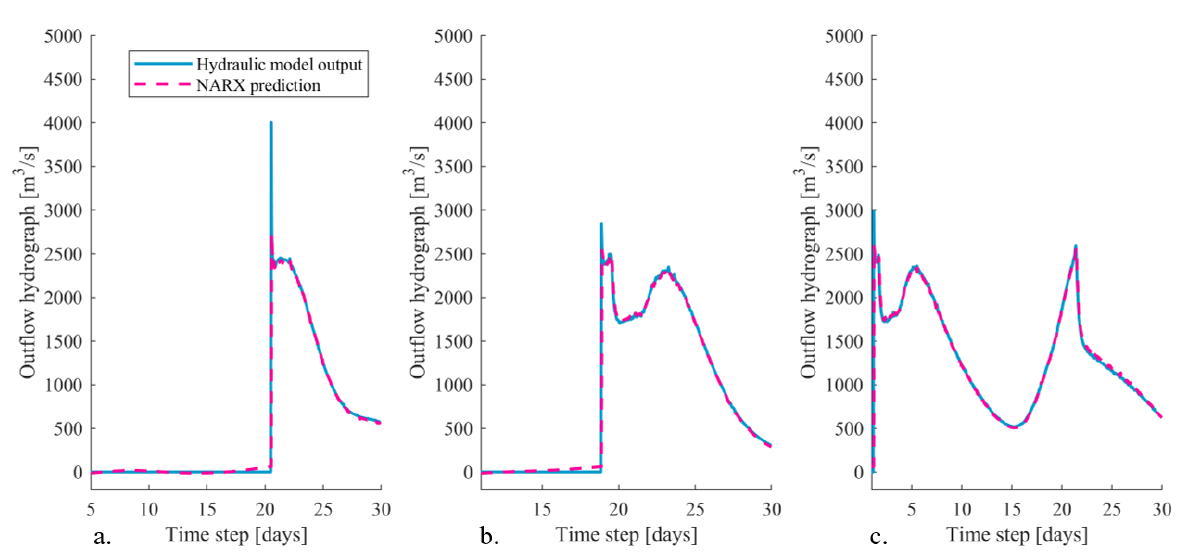
Figure 10. ( a – c ) Multiple outflow hydrographs at the IJssel river dike breach location predicted by the hydraulic model and the NARX network as a result of the upstream discharge waves presented in Figure